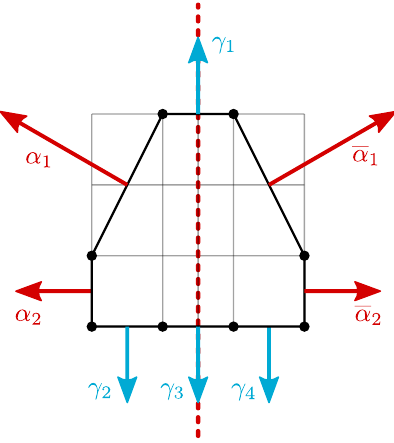
Figure 21. A generic singularity with a vertical axis